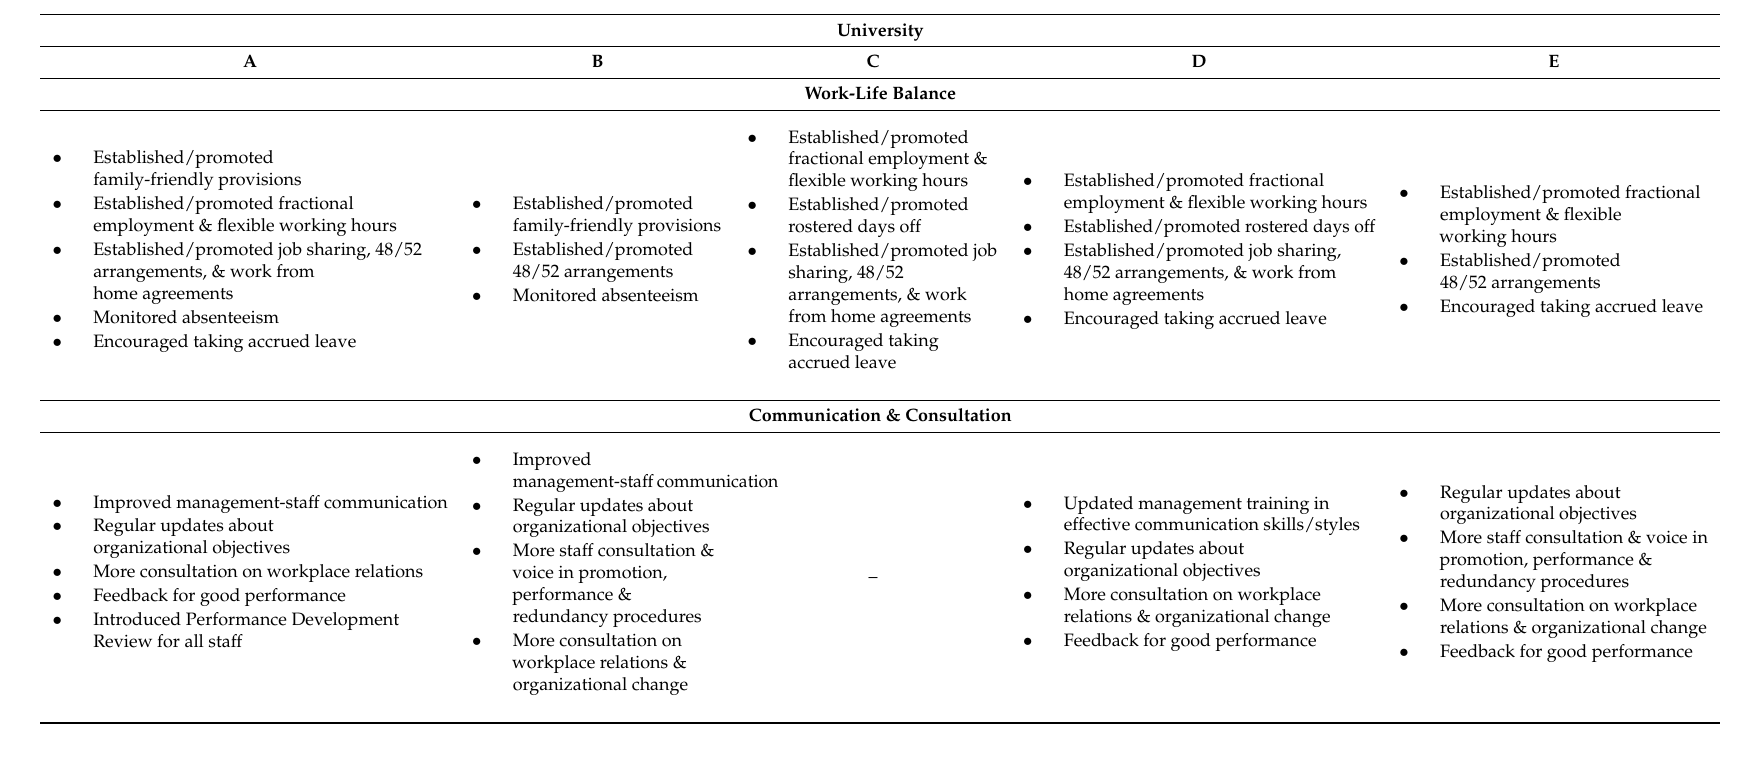
Table 4. Interventions to Enhance Work-Life Balance and